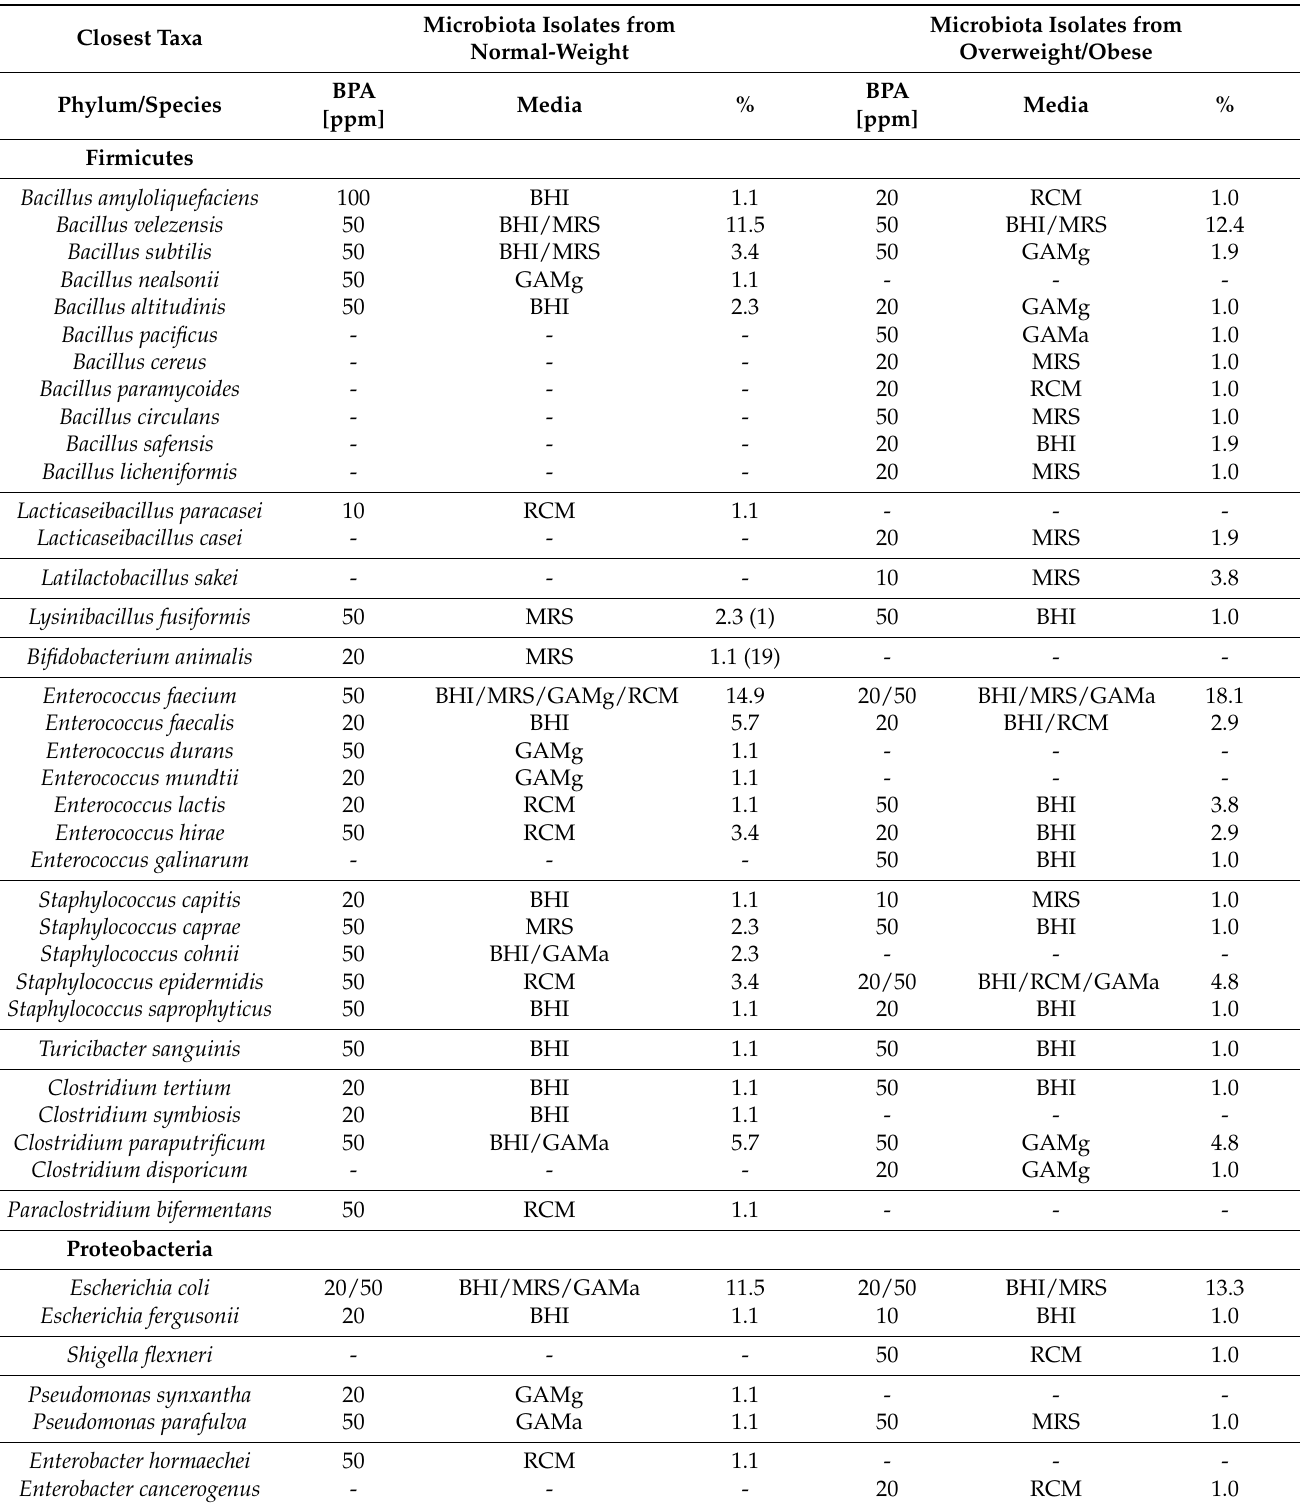
Table 3. BPA-tolerant cultured bacteria taxa from the gut microbiota of normal-weight and over-